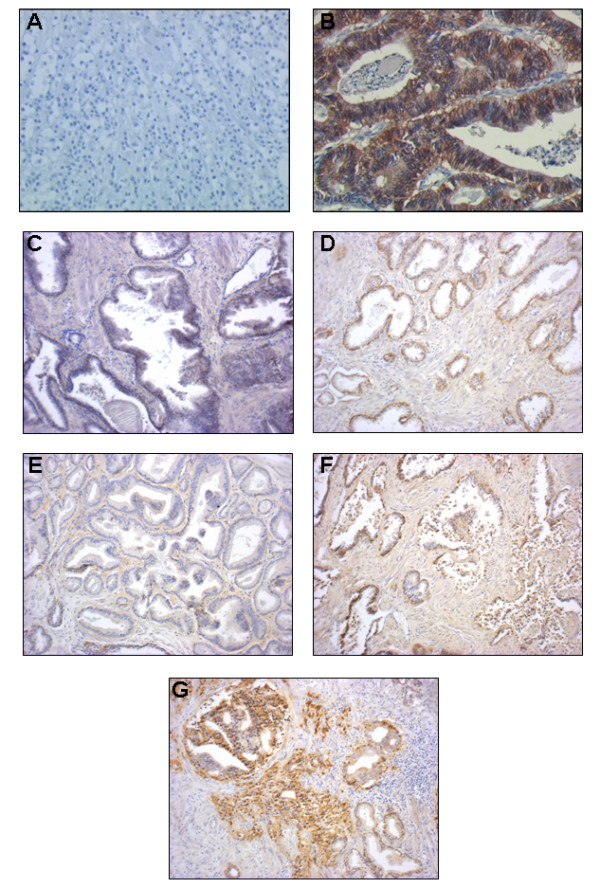
Different EGFR pattern of expression in normal and PCs tissues revealed by immunohistochemistry. A: negative control: lobular breast carcinoma not expressing EGFR. B: positive control: colon carcinoma expressing high levels of EGFR. C: normal prostate tissue not expressing EGFR. D: normal prostate tissue expressing EGFR. E: PC tissue not expressing EGFR. F-G: PC tissues expressing different pattern of EGFR. (Magnification 10X).